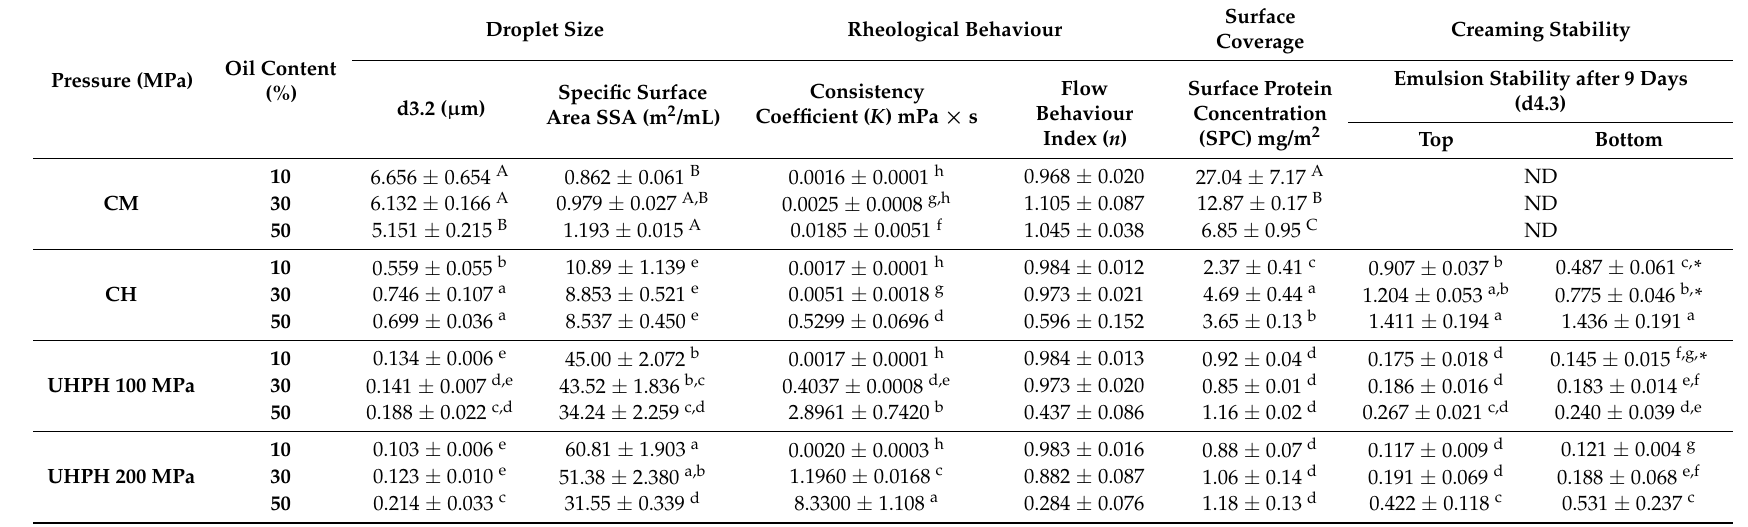
Table 2. Mean ± SD of droplet size distribution (d3.2, µ m), specific surface area (SSA, m 2 /mL), surface protein concentration (SPC, mg/m 2 ), rheological characteristics (flow and consistency indices) and physical creaming stability (d4.3, µ m) value at the top and bottom of tube after 9 days of storage at room temperature) of O/W emulsions containing 4% ( w / w ) whey protein isolate plus sunflower and olive oils (10%, 30% and 50%) and prepared by colloid mill (CM), conventional homogenization (15 MPa) and ultra-high pressure homogenization at 100 and 200